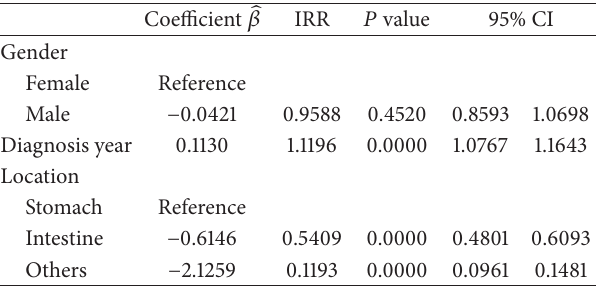
Table 2: Poisson regression for multivariate analysis of GIST incidence.